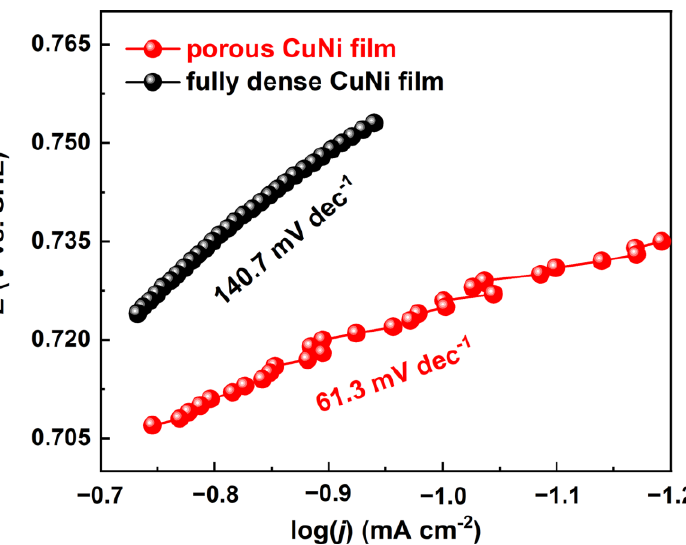
Figure 7. Tafel slopes of porous and fully dense CuNi films obtained from the HER polarization curves. Scan rate: 5 mV s − 1 . curves. Scan rate: 5 mV s − 1